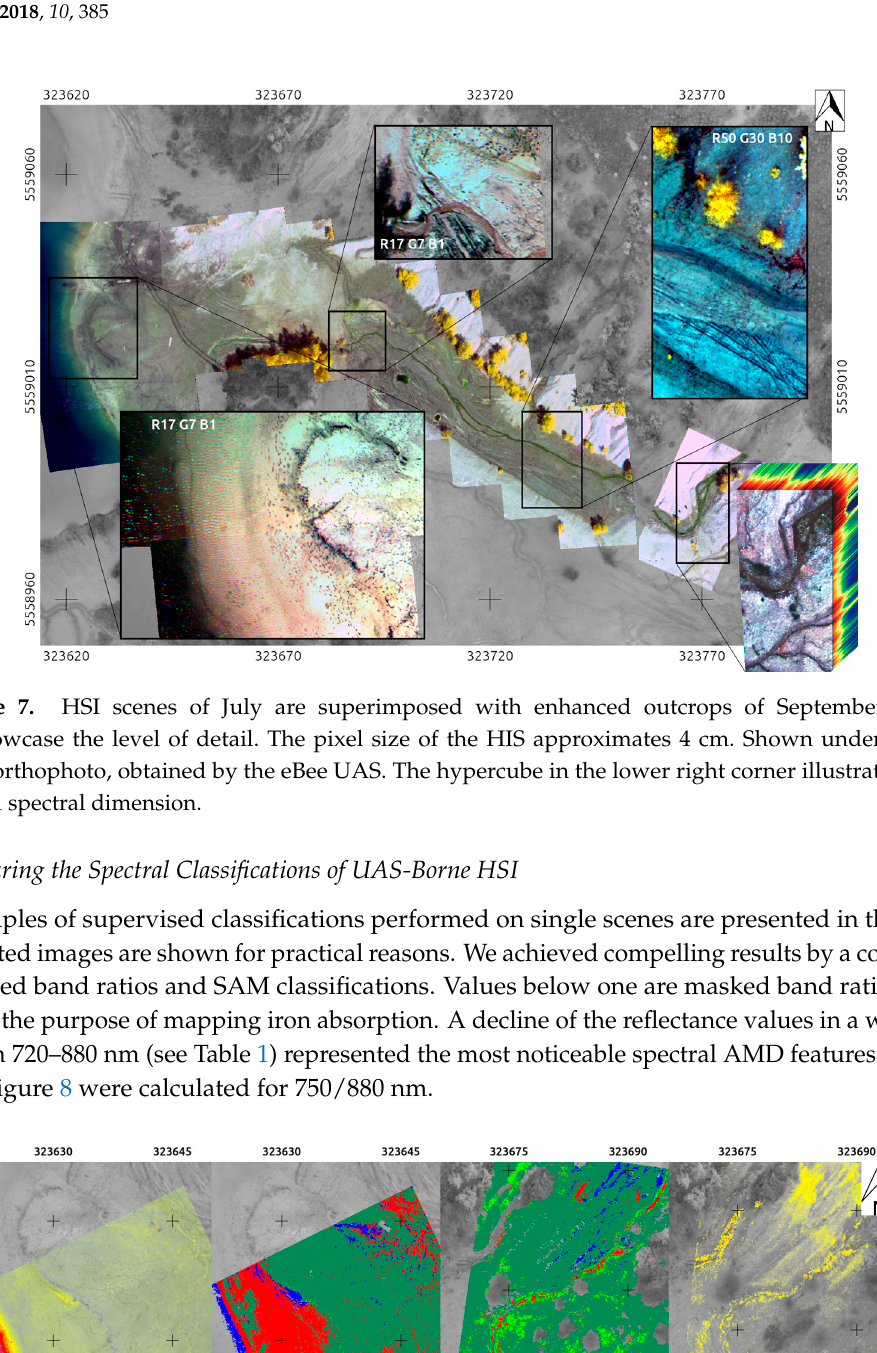
Figure 9. The SAM classification with the four endmembers is applied for scenes from the four campaigns, involving the same surface feature. The legend is applicable for all four images. ( A ) April; ( B ) May; ( C ) July; and ( D ) September.